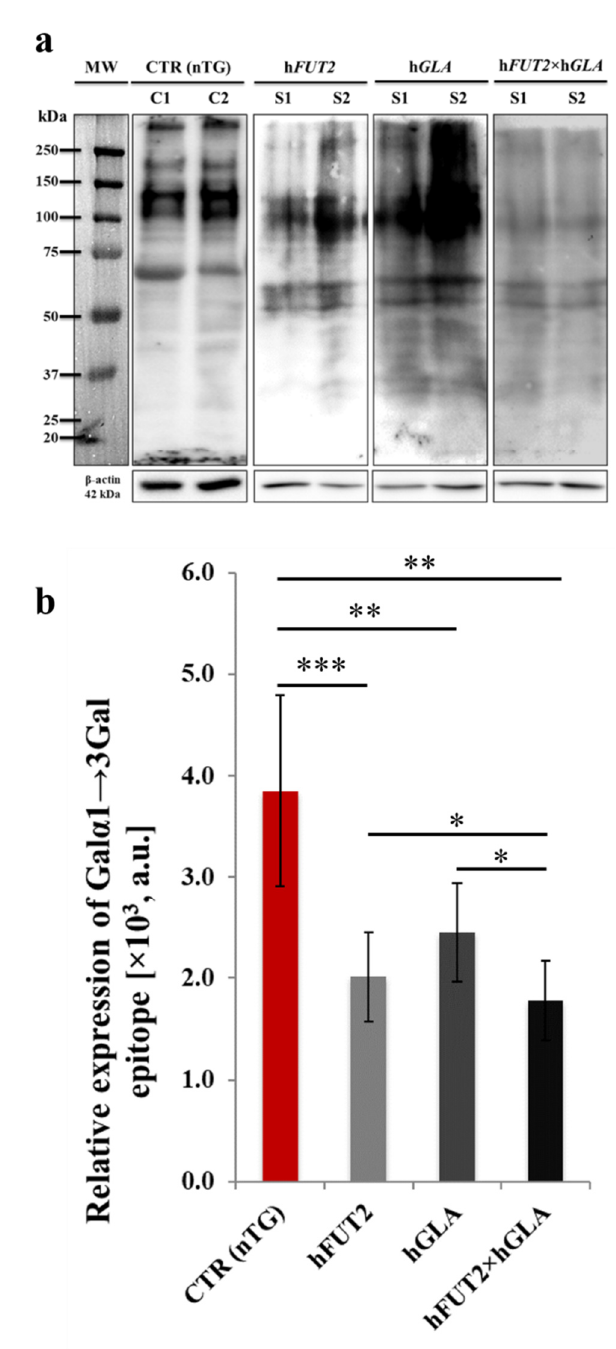
Figure 6. Analyzing semiquantitative profiles of Gal α 1 → 3Gal epitope expression by lectin blotting of protein samples isolated from ex vivo-expanded control nontransgenic (CTR nTG) PEKs and their